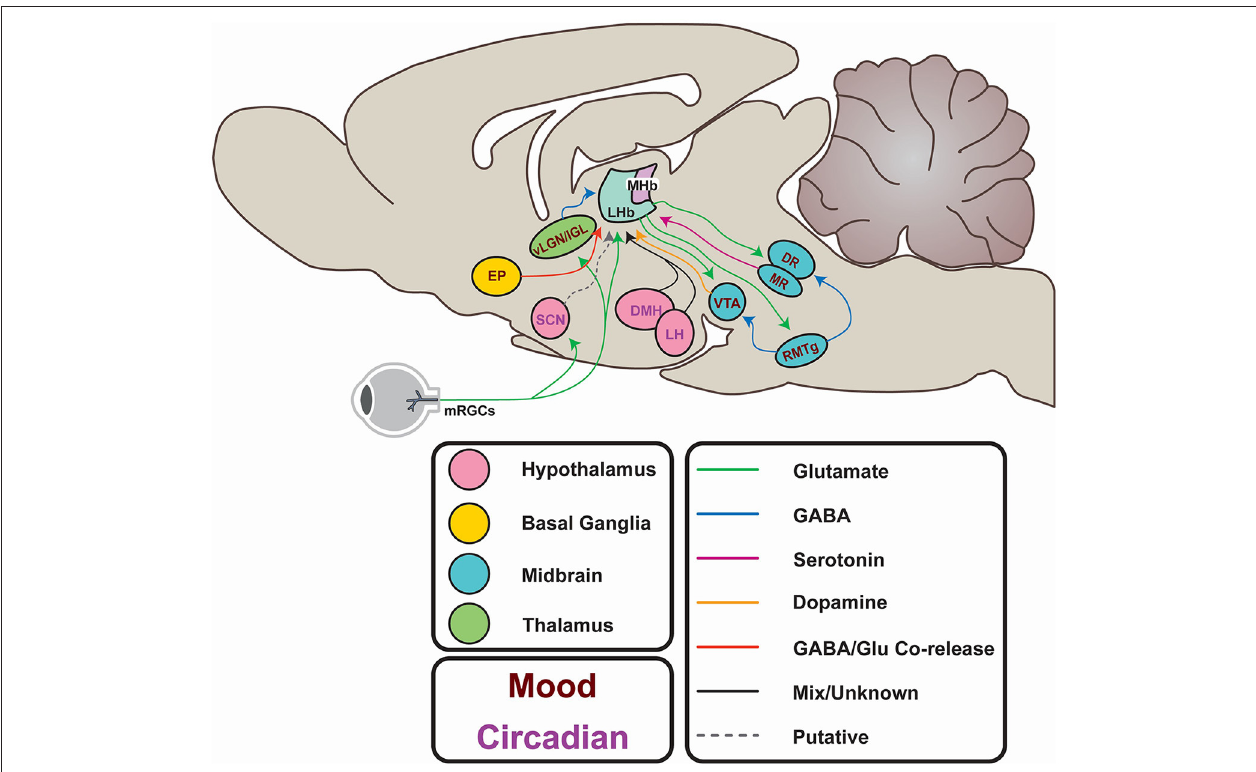
FIGURE 3 | Afferents and efferents of the LHb. From the hypothalamus, the lateral hypothalamic area (LH) and dorsomedial hypothalamus (DMH) potentially entrain the LHb to circadian rhythms. These areas receive input from the suprachiasmatic nucleus (SCN), which in turn may entrain the LHb, either directly ( via putative Prokineticin 2-containing efferents) or indirectly via SCN innervation of the LH and DMH. The SCN itself is entrained to the external light-dark cycle through photic information directly conveyed by non-image forming retinal projections. Similar projections from melanopsin-expressing retinal ganglion cells (mRGCs) terminate in areas immediately adjacent to the LHb. Additionally, the LHb may receive photic information via the ventral lateral geniculate or Intergeniculate nucleus (vlGN/IGL). Input from the entopeduncular nucleus (EP) encodes anti-reward, and activity in this pathway is elevated in depression. Excitatory projections to the rostromedial tegmental area (RMTg) provides feedforward inhibition to the ventral tegmental area (VTA) and the raphe nuclei (DR and MR) which regulates mood and reward learning. The VTA provides reciprocal GABAergic projections to the LHb to provide feedback inhibition and encode reward. The DR provides serotonergic projections which inhibit excitatory innervation of the LHb from the EP, and itself generates excitatory postsynaptic